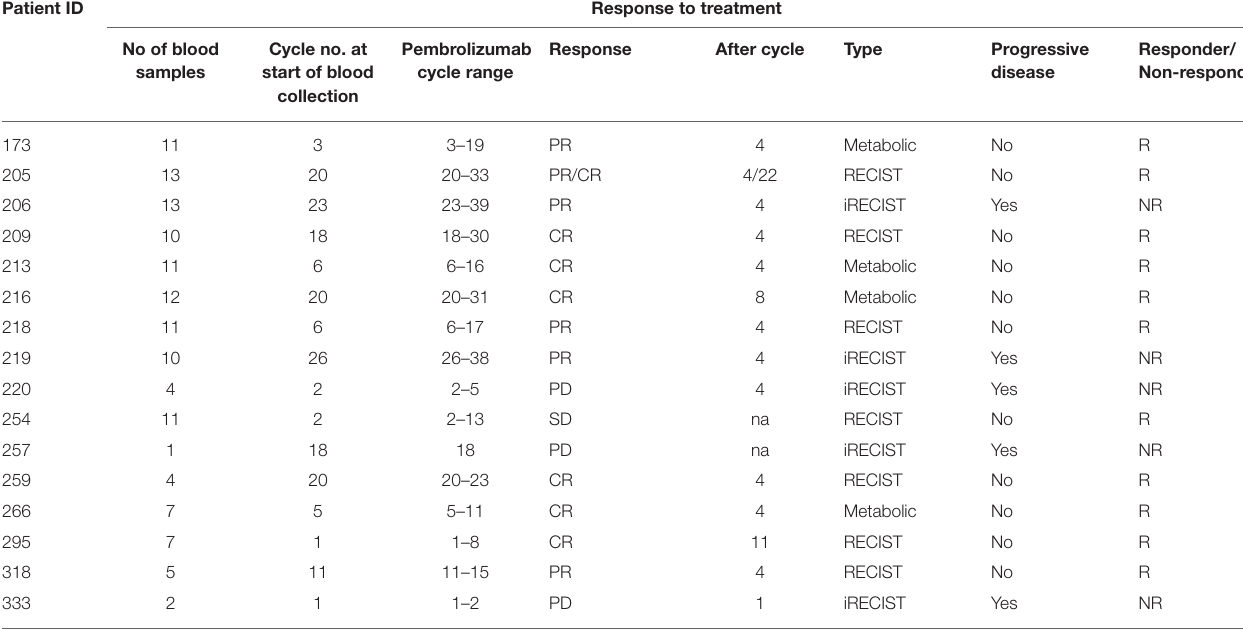
TABLE 2 | Cohort response to pembrolizumab. Patient